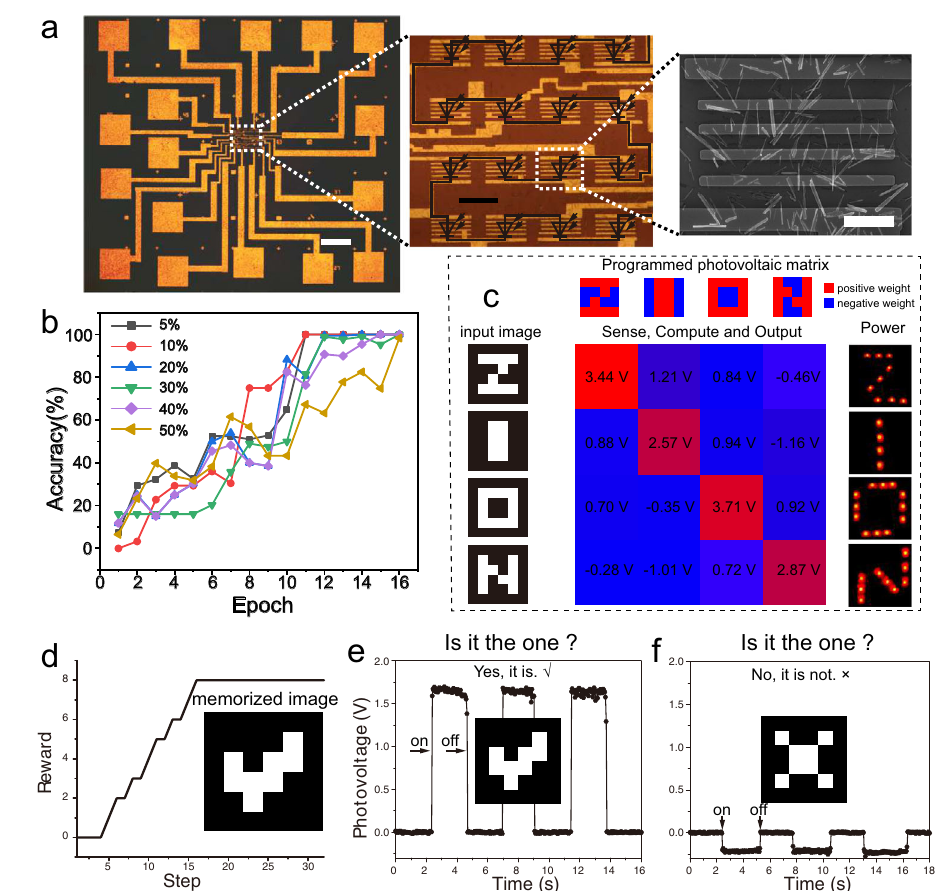
Fig. 3 | Full-functional arti fi cial vision system implanted in PV-RAM array. a Optical microscopy images (left and middle) and scanning electron microscopy image of the PV-RAM array. Scale bar, left: 100 μ m, middle: 20 μ m, right: 5 μ m. b Learning curve of accuracywith different levels of noise. c Demonstration of the arti fi cial vision system. The binary weights were presented by the programmed